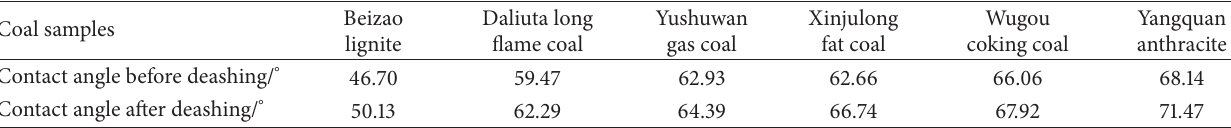
Table 5: Contact angles between coal sample and distilled water before and after